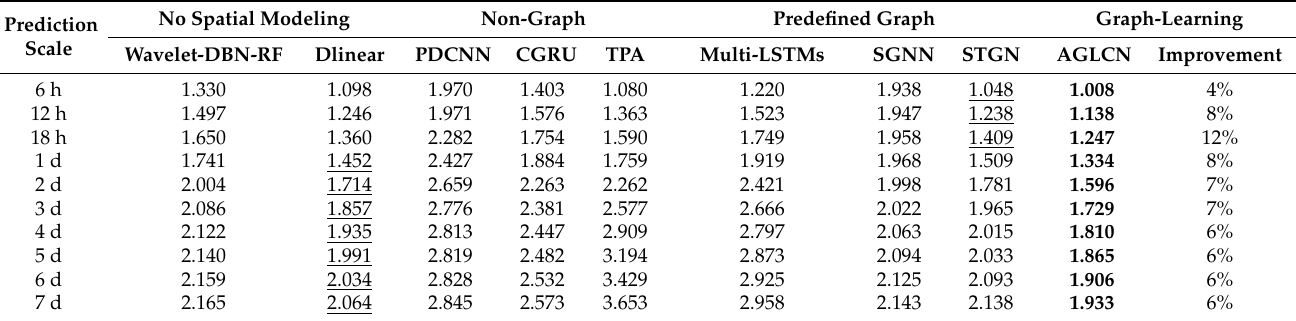
Table 1. MAE of forecasting methods for 40 nodes.